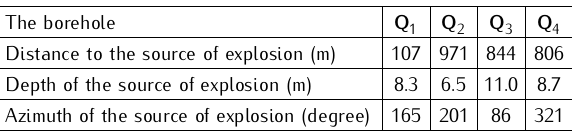
Table 1. The parameters of the